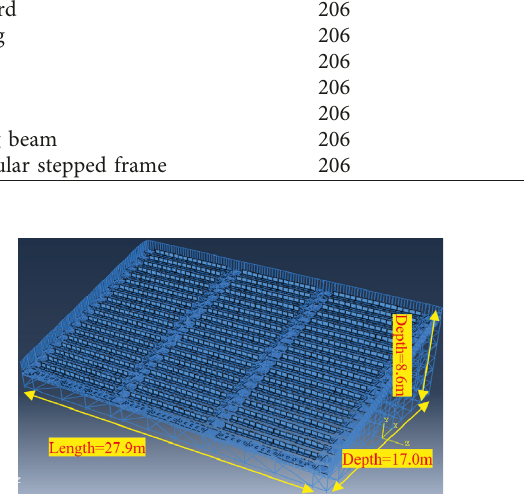
Figure 17: The finite element model of temporary